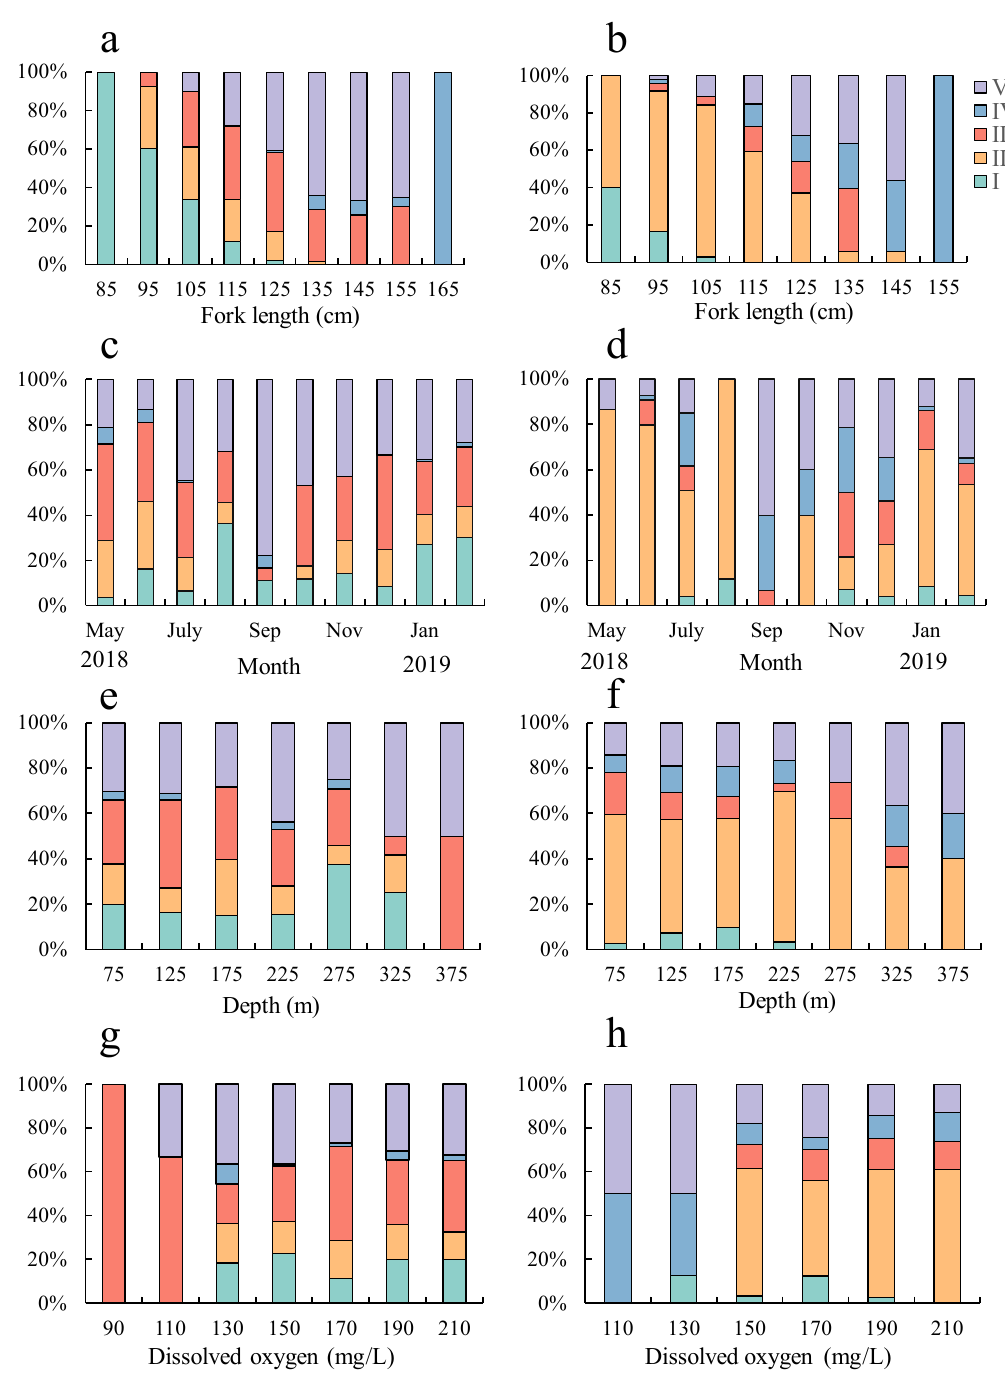
Figure 5. Proportions of the sexual maturity stages found in T. albacares (( a ) male, FL; ( b ) female, FL; ( c ) male, month; ( d ) female, month; ( e ) male, water depth; ( f ) female, water depth; ( g ) male, dissolved oxygen; ( h ) female, dissolved oxygen).